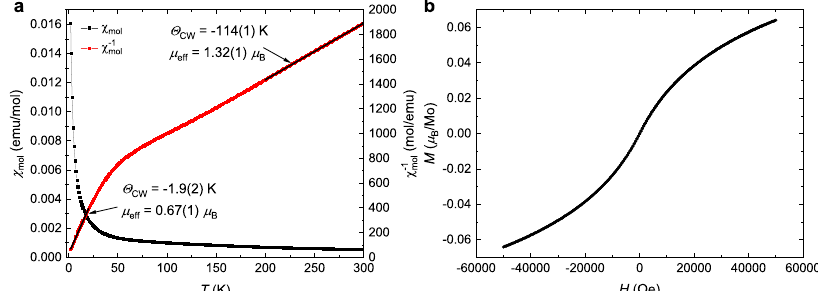
Fig. 2 Magnetic susceptibility. a DC magnetic susceptibility (black) and inverse molar magnetic susceptibility (red) of Ba 2 LuMoO 6 as a function of temperature. Only the ZFC data is shown as the ZFC and FC curves overlap. The magnetic susceptibility appears paramagnetic with no transitions observed down to 2 K. In the inverse susceptibility two linear temperature regimes are observed: one at high temperatures (as expected) and one at low temperatures. b Field-dependent magnetization curve at 2 K. The M ( H ) curve has an S shape without any hysteresis as expected for paramagnetic materials at low